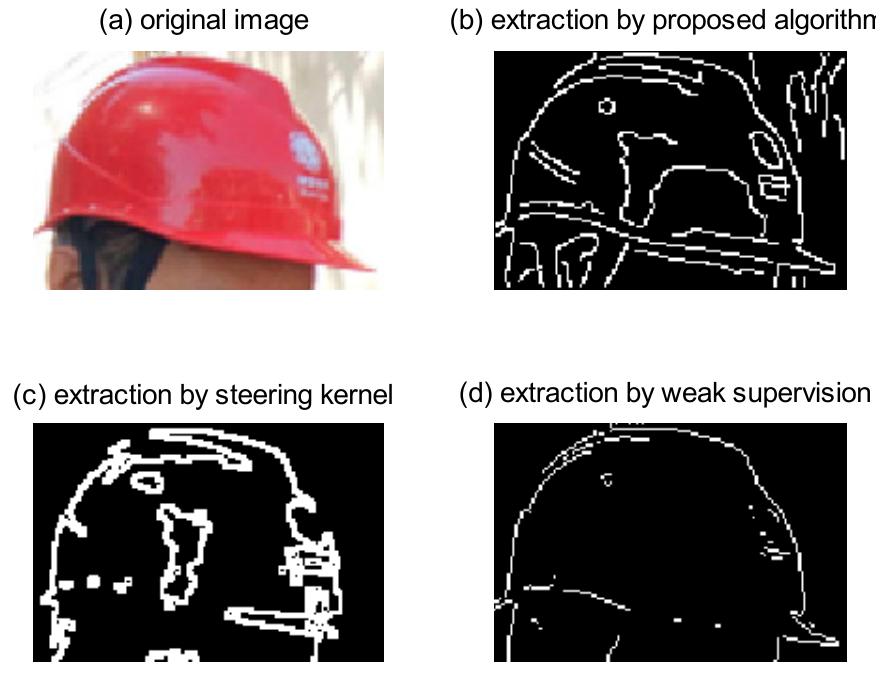
Figure 8. Comparison of the effectiveness of the proposed and existing feature extraction algorithms for feature extraction of a helmet.